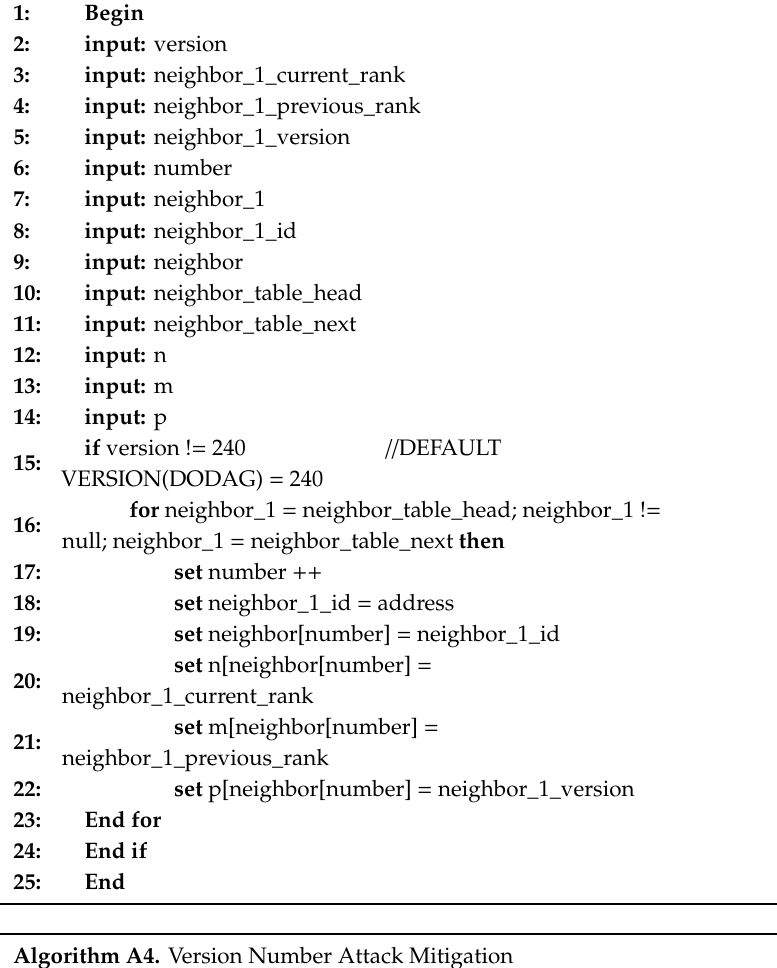
Algorithm A3. Checking the Condition of the Initial Default Version Number